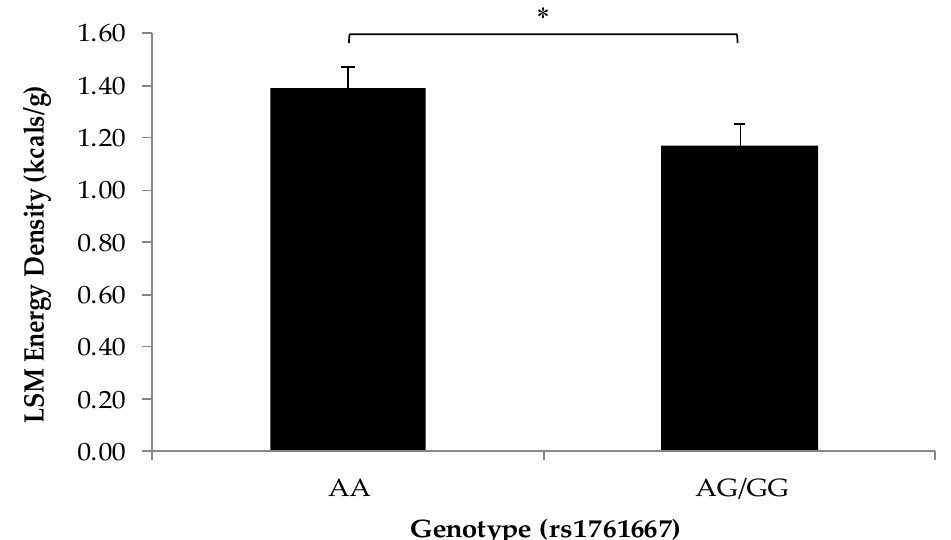
Figure 1. Least squares means of energy density of snacks by rs1761667 genotype Statistical differences between the total energy density of snacks by genotypes for rs1761667 of the CD36 fat taste receptor gene were determined using generalized estimating equations ( n = 47; * p = 0.007) and a recessive genetic model [6]. Children carrying the AA genotype ( n = 13), predicted to prefer fat more than the AG/GG genotypes ( n = 34), consumed snacks with a higher total energy density than children carrying the G allele. Values are reported as least squares means + SE.